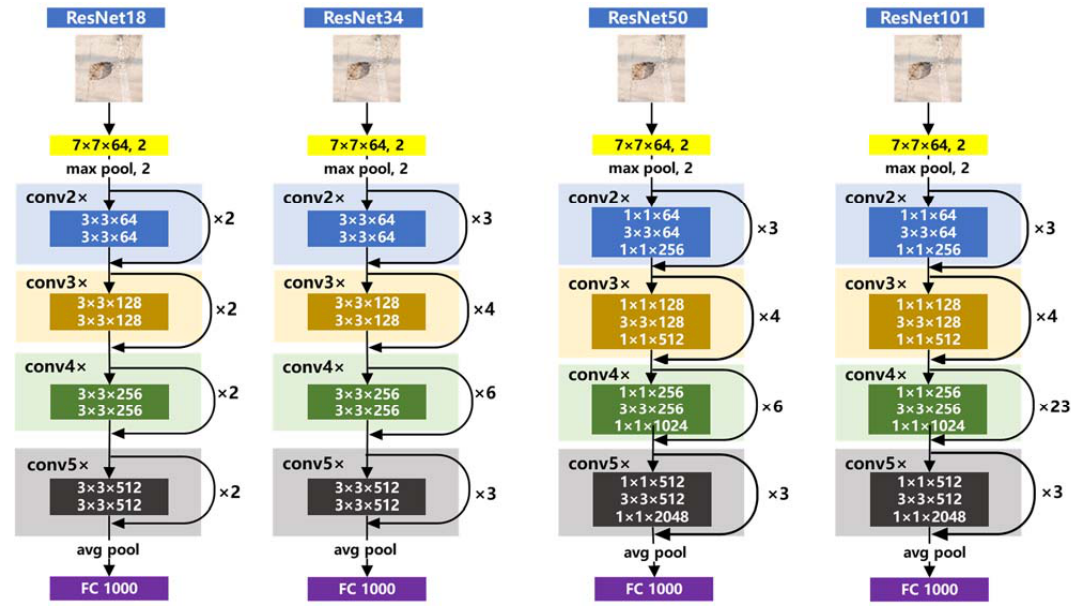
Figure 3. Comparison of ResNet101 network structure with other residual networks (ResNet18, ResNet34, and ResNet50).